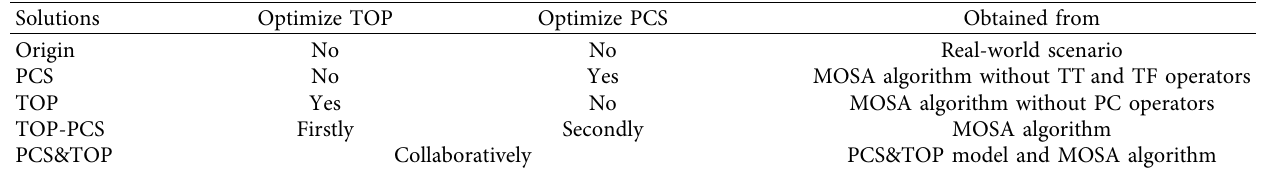
Figure 14: The variation of the objective function in each Table 5: The explanation of comparison experiments.